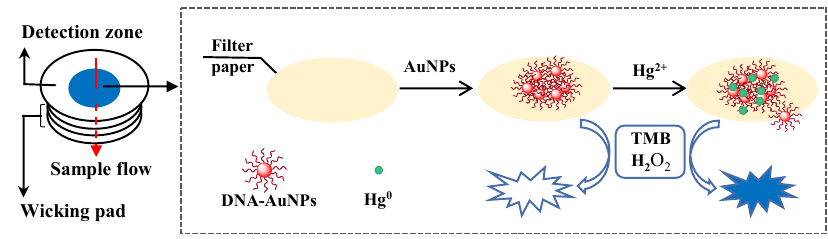
Figure 1. Schematic of paper device fabrication.